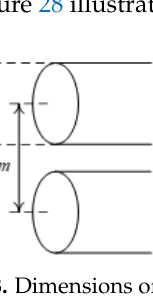
Figure 27. MS09404A Mixed Signal Oscilloscope of a 4 GHz bandwidth having two channels. Figure 28 illustrates the dimensions of the transmission line.